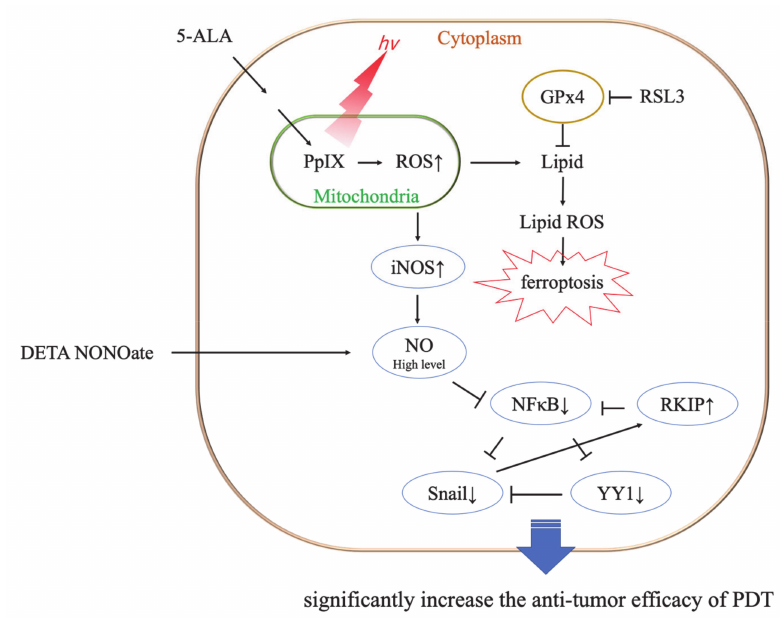
Figure 9. Representative mechanism of ferroptosis induced by photodynamic therapy (PDT), and the cytotoxic role of PDT and nitric oxygen (NO) donors. RSL3 inhibits the activity of glutathione peroxidase4 (GPx4) by covalent binding with GPx4 and induces ferroptosis [26]. No donor and PDT-induced high levels of NO result in significant antitumor cytotoxicity